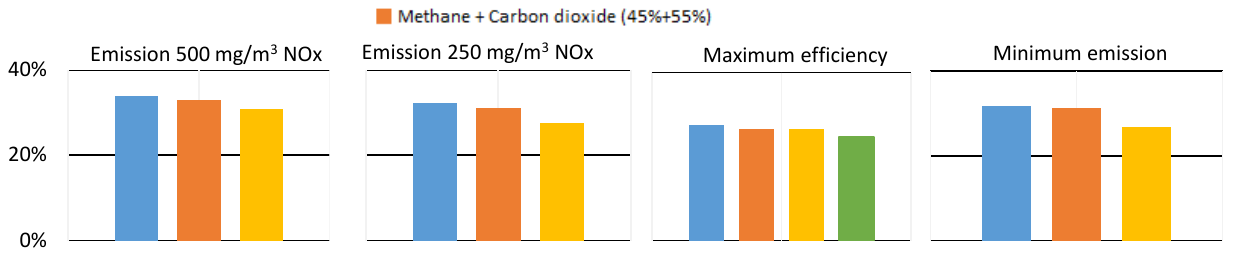
Fig. 6. Genset efficiency at 50% load for different NO x emission settings